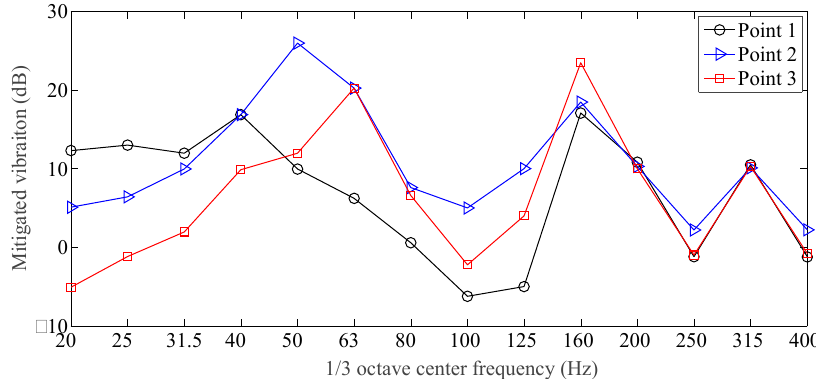
Figure 14. Mitigated vibration for the vibration mitigation slab track plate.